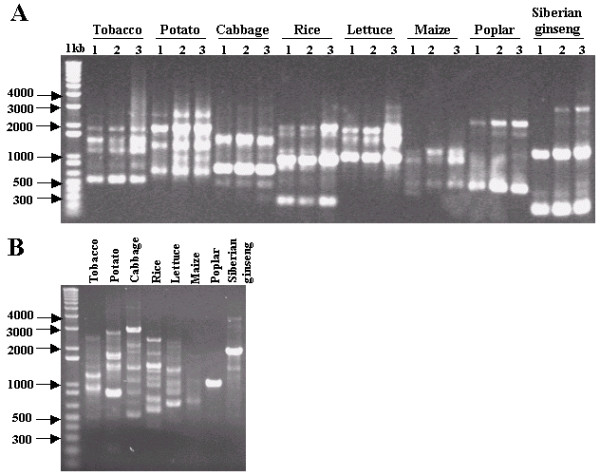
RAPD fingerprints of all the DNA samples with primers (A) RAPD-1 (5'-CCACAGCAGT-3') and (B) RAPD-2 (5'-AAGCCCGAGG-3'). (A) Lane 1, the DNA template was the supernatant from the first phenol:chloroform:isoamyl alcohol extraction (protocol 1); lane 2, the DNA template was the supernatant after two phenol:chloroform:isoamyl alcohol extractions and one chloroform extraction (protocol 2); lane 3, the DNA template was prepared with an additional ethanol precipitation (protocol 3). (B) PCR products amplified using only the DNA template from protocol 1. 1 kb, DNA molecular weight ladder.